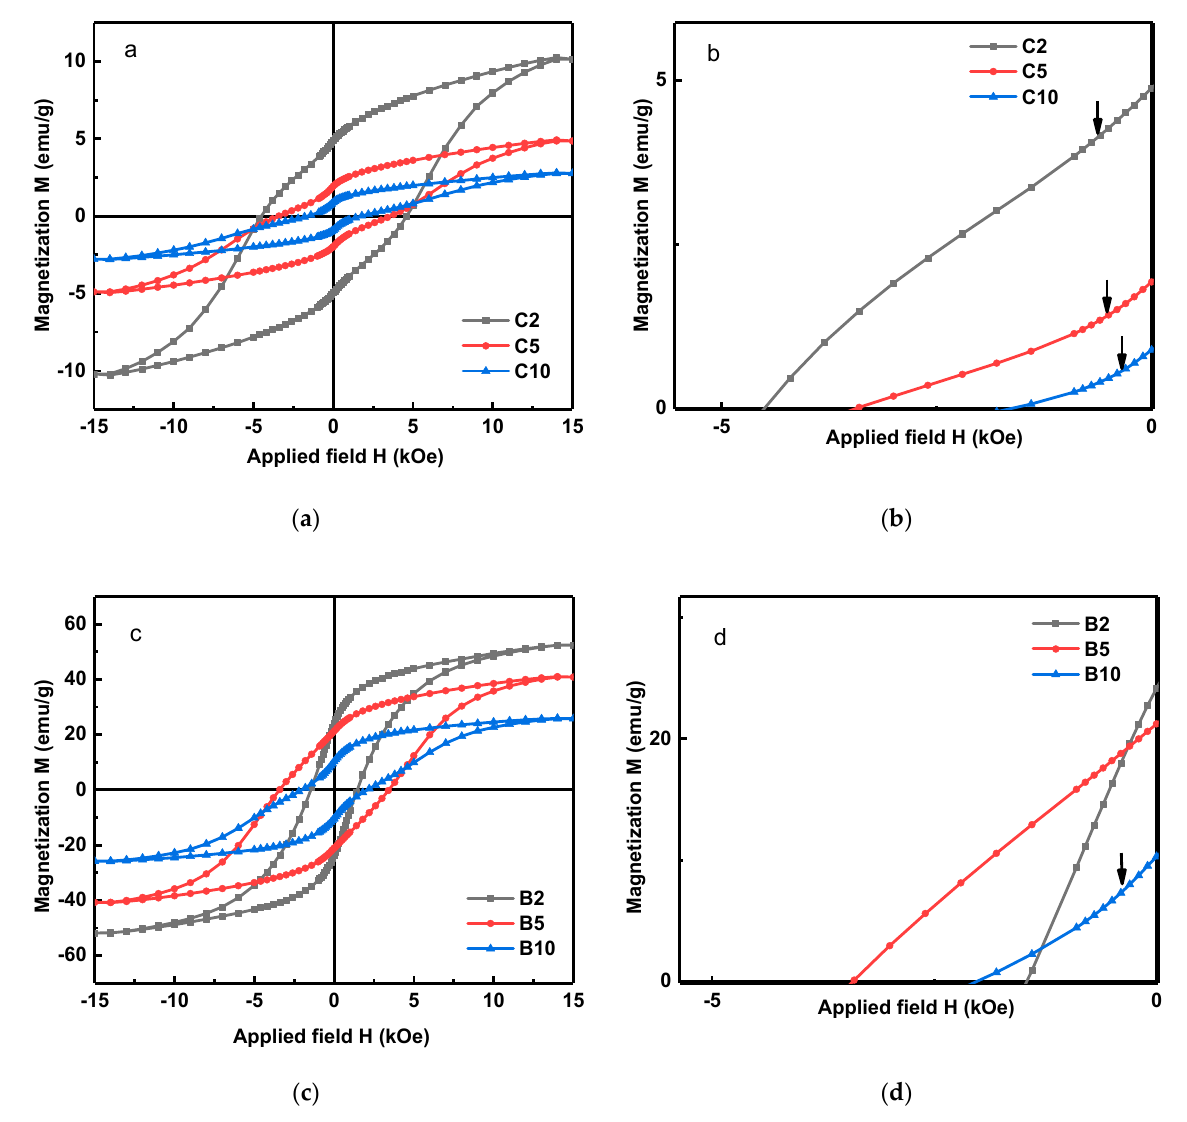
Figure 6. M-H hysteresis loops for Mn 52 Al 45 . 7 C 2 . 3 samples prepared by ( a , b ) cylinder container and ( c , d ) barrel container at different milling times (t = 2, 5, and 10 h); the arrows show the kinks caused by defects.